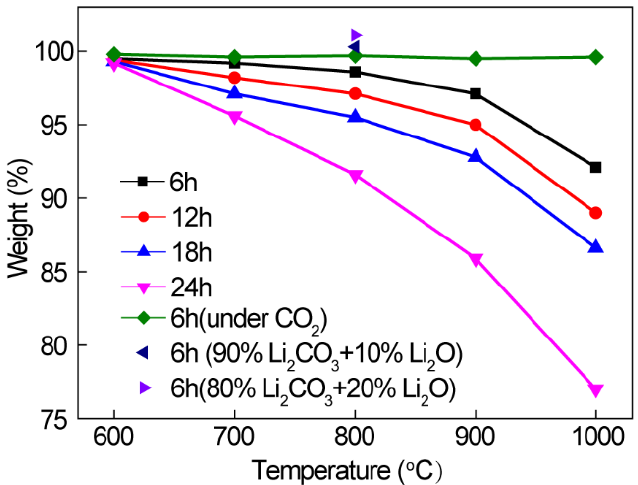
Figure 1. Thermodynamic stability of Li 2 CO 3 (or Li 2 CO 3 + Li 2 O) at different temperatures. Li 2 CO 3 thermal decomposition: